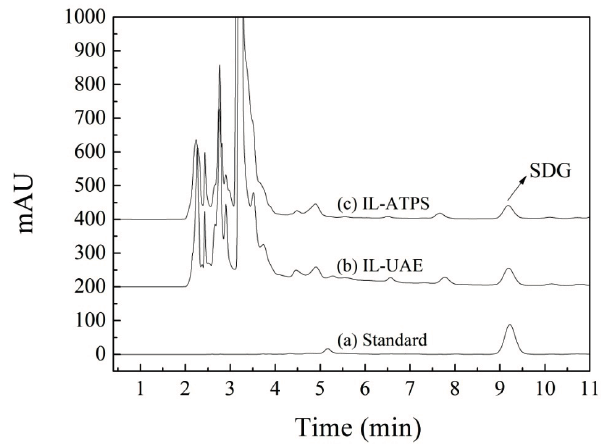
Figure 5. HPLC chromatograms for (a) SDG standard; (b) IL-UAE sample; and (c) IL-ATPS sample.